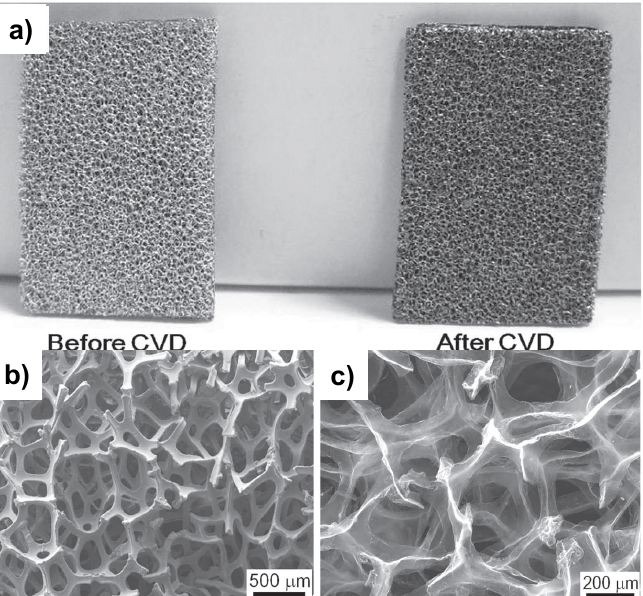
Figure 2. Photographs of ( a ) Ni foam before and after the growth of graphene, SEM images of ( b ) 3D graphene networks grown on Ni foam after CVD, and ( c ) 3D graphene networks after removal of Ni foam. Reprinted with permission from ref. [5]. Copyright 2011 WILEY-VCH Verlag GmbH & Co.